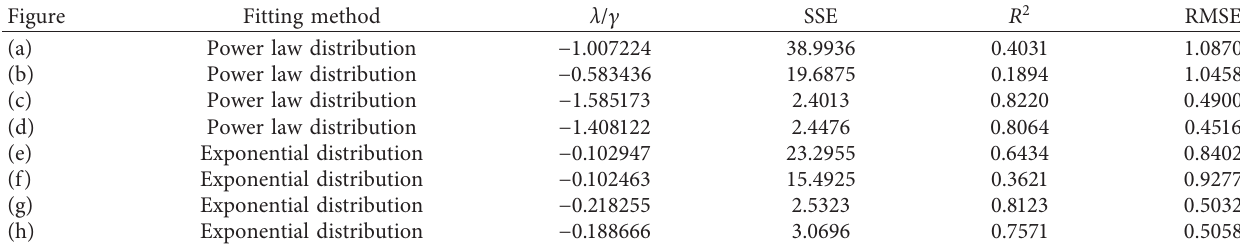
Table 3: Statistics of goodness of fit parameters.